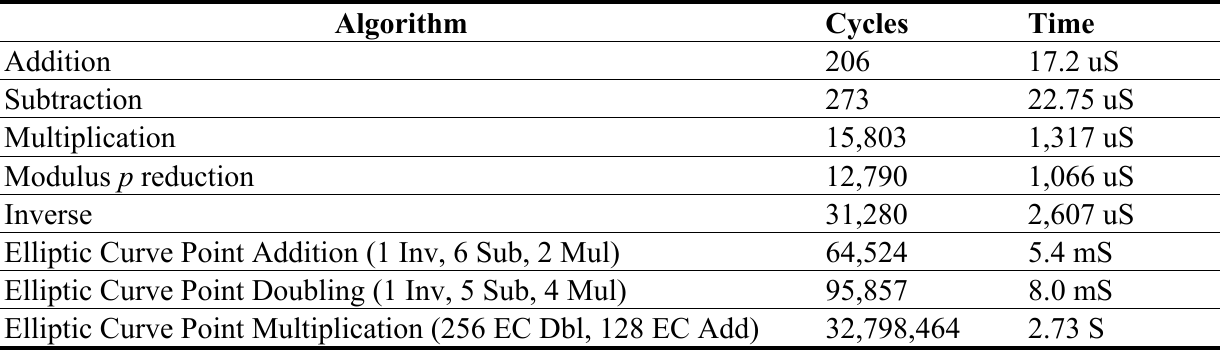
Table 4. The Algorithm Execution Time